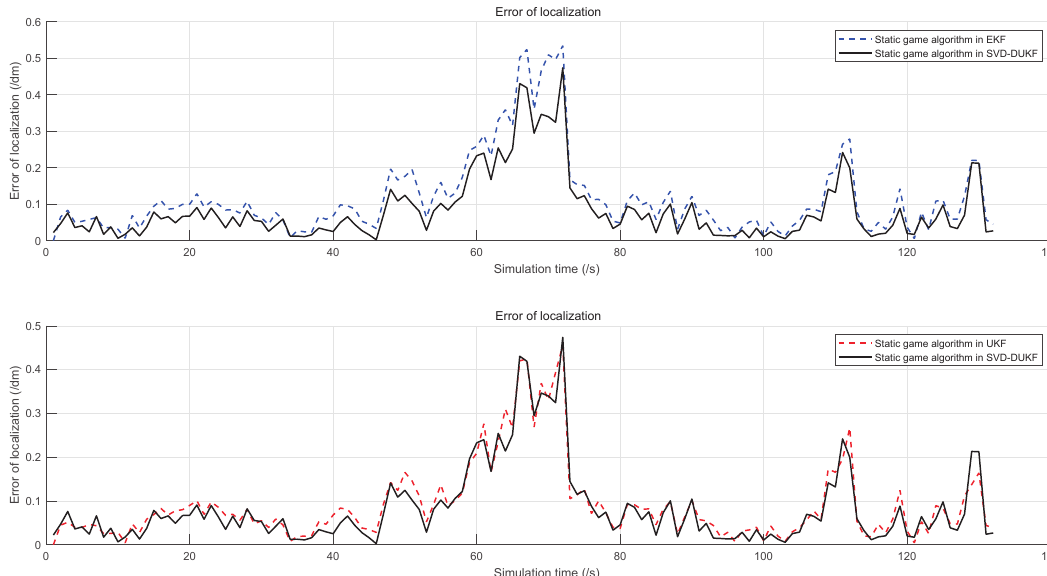
Figure 9. The error of localization on the game theory EKF, the game theory UKF, and the game theory SVD-DUKF. Table 5. The average calculation time of SR-CKF and the static game theory-based SVD-DUKF in 50